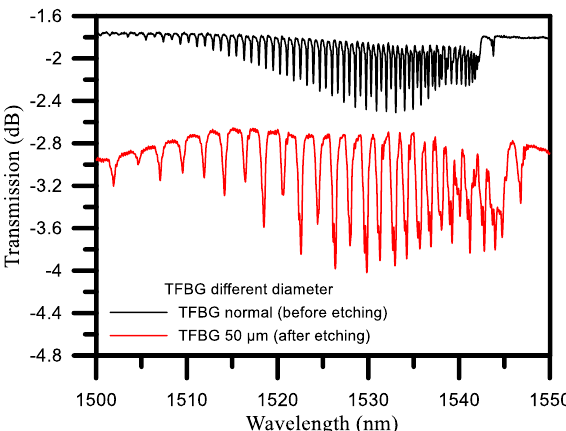
Figure 7. TFBG spectrum, before etching (Black line), after etching (Red line).